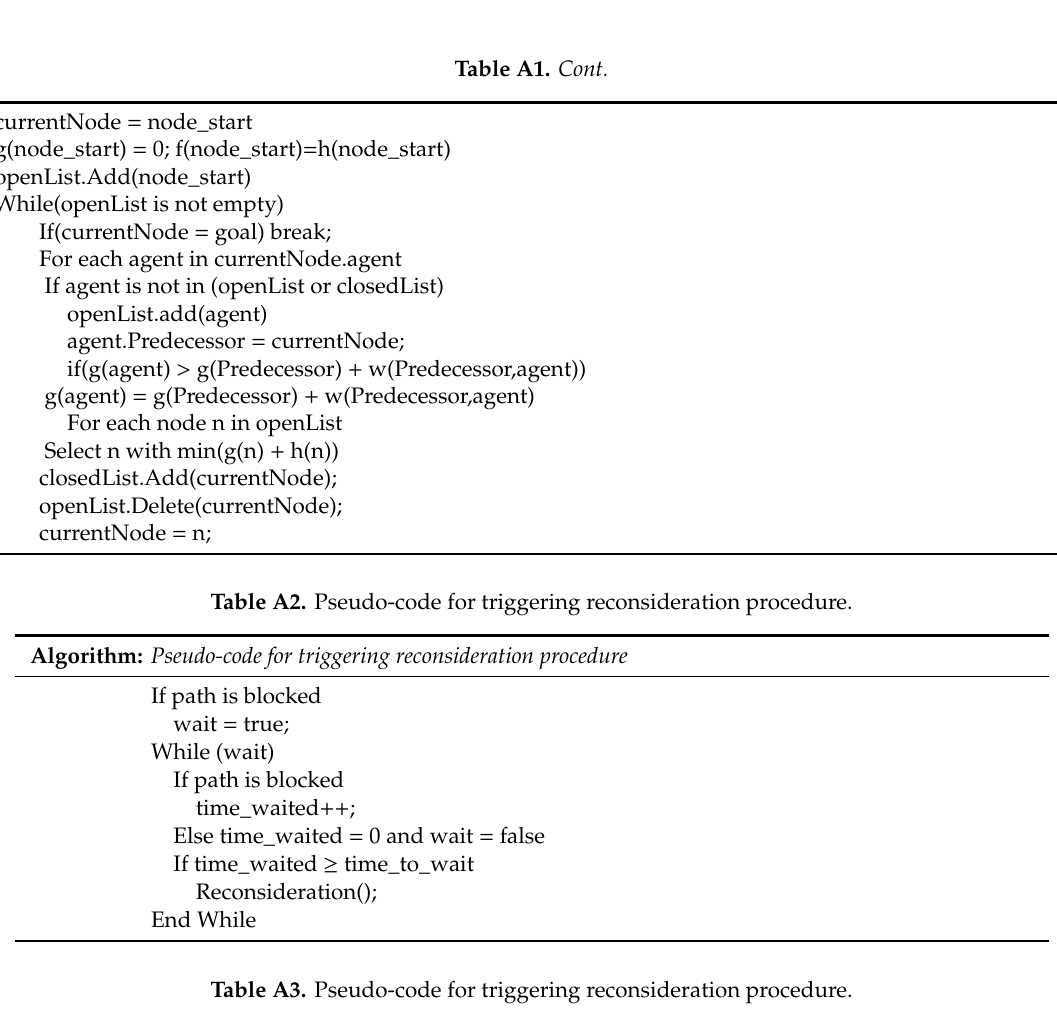
Table A3. Pseudo-code for triggering reconsideration procedure. Algorithm: Pseudo-code for crowd-coe ffi cient